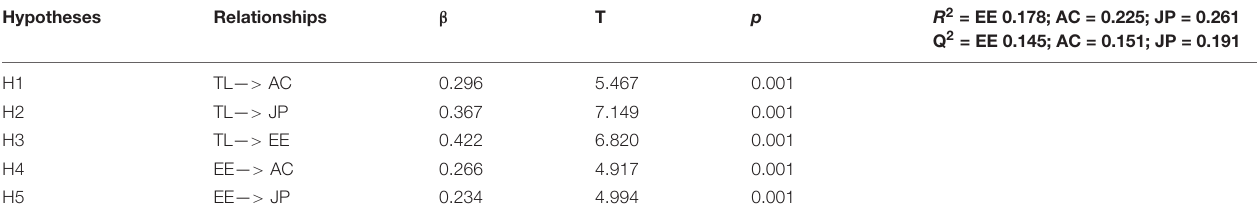
TABLE 4 | Table Path coefficients (direct effects). Hypotheses